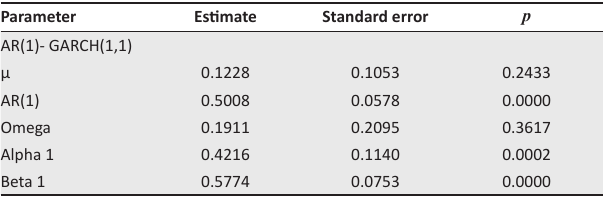
TABLE 3a: South Africa – Specification for the rate of change of interest rate: A [AR(1)- GARCH(1,1)] model. Parameter